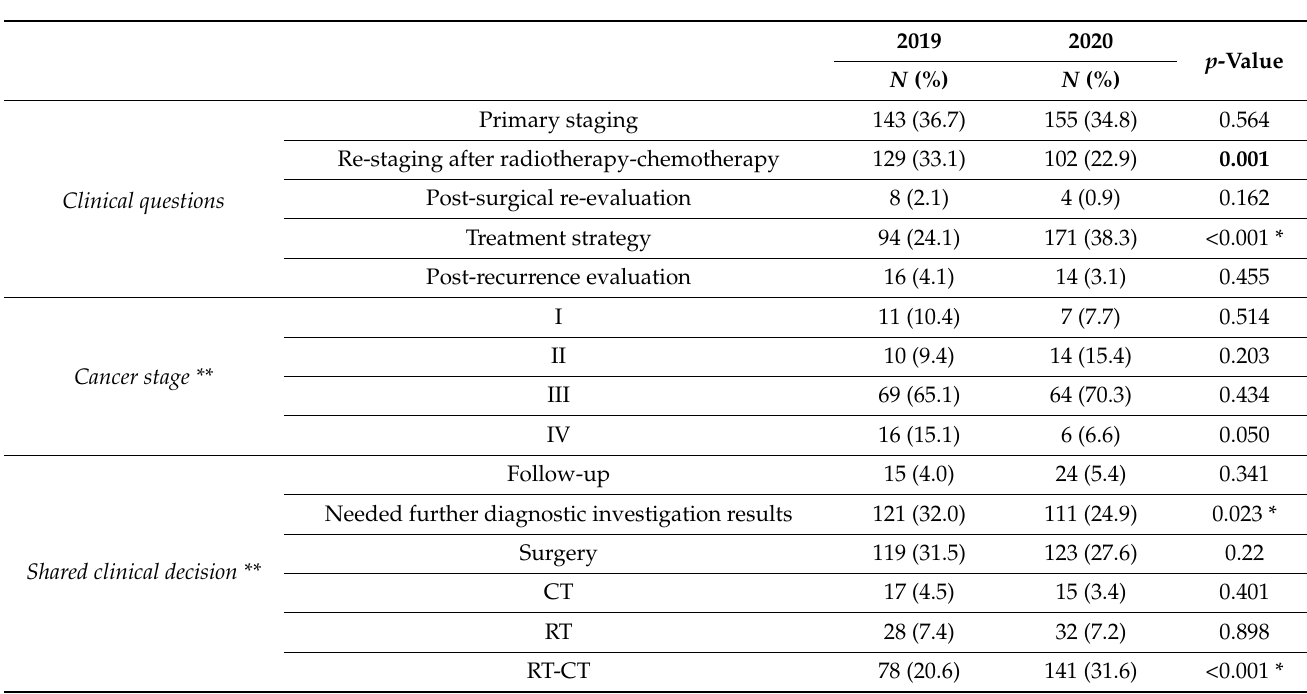
Table 4. RC-MTB patient-related